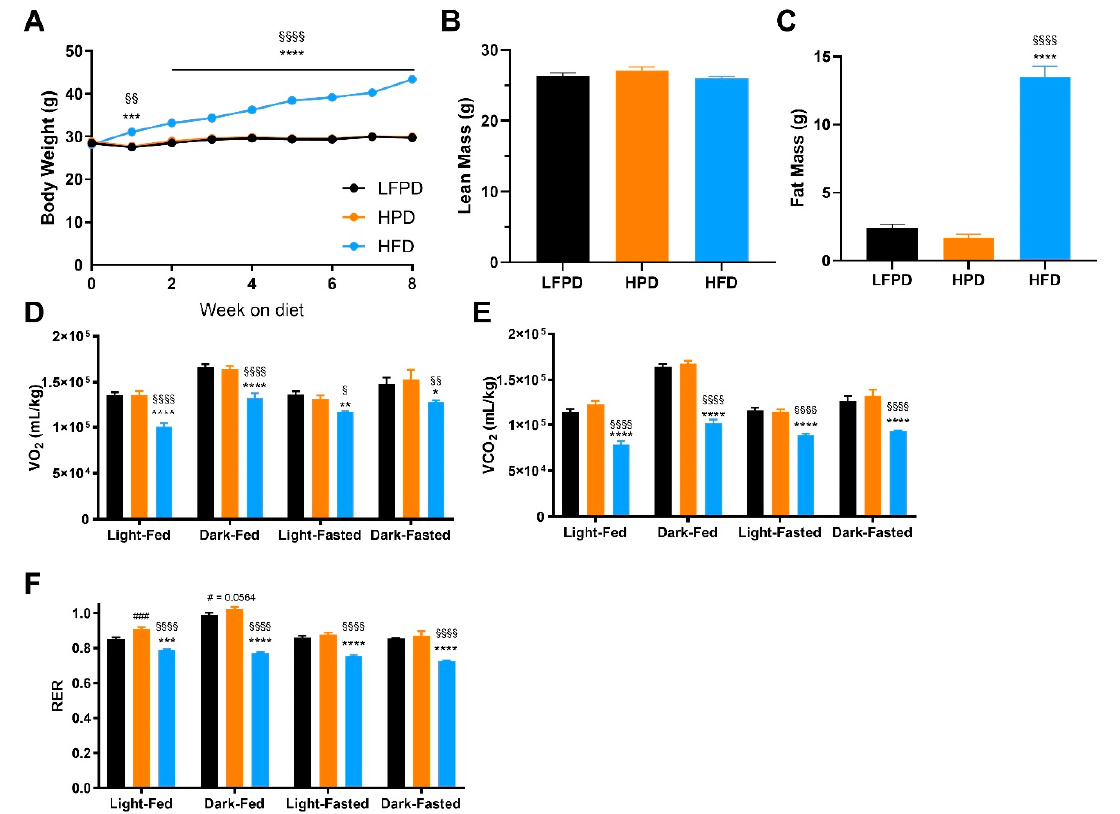
Figure 1. Six weeks of HFD impaired glucose metabolism. ( A ) Body weight, ( B ) Total lean mass, ( C ) Total fat mass, ( D ) Oxygen consumption (VO 2 ), ( E ) Carbon dioxide production (VCO 2 ), and ( F ) Respiratory Exchange Ratio after 6 weeks of diet intervention. N = 14–30 per group for ( A – C ), n = 7–10 per group for ( D – F ). One or two-way ANOVA were used with Tukey’s multiple comparison test (* p < 0.05, ** p < 0.01, *** p < 0.001, **** p < 0.0001 LFPD vs. HFD, § p < 0.05, §§ p < 0.01, §§§§ p < 0.0001 HPD vs. HFD, # p < 0.05, ### p <0.001 LFPD vs. HPD). Data are expressed as the mean ± SEM.